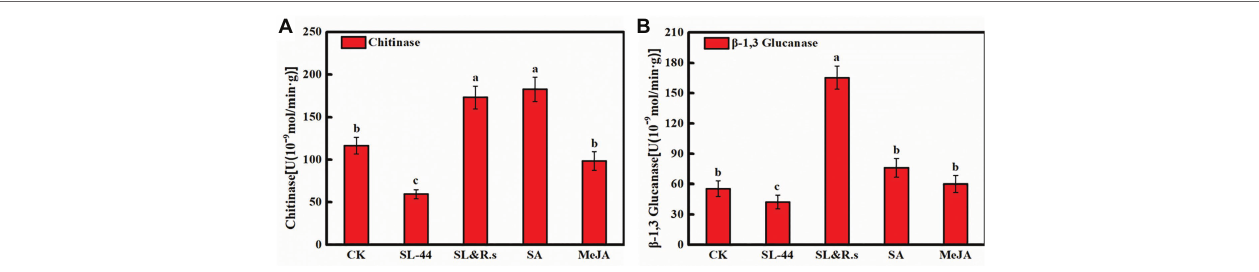
FIGURE 4 | Chitinase and β -1,3-glucanase of pepper foliage in different treatments of chitinase activity (A) and β -1,3-glucanase activity (B) . Each value represents the mean ± SD ( n = 6). Different letters above the columns indicate significant differences at p <